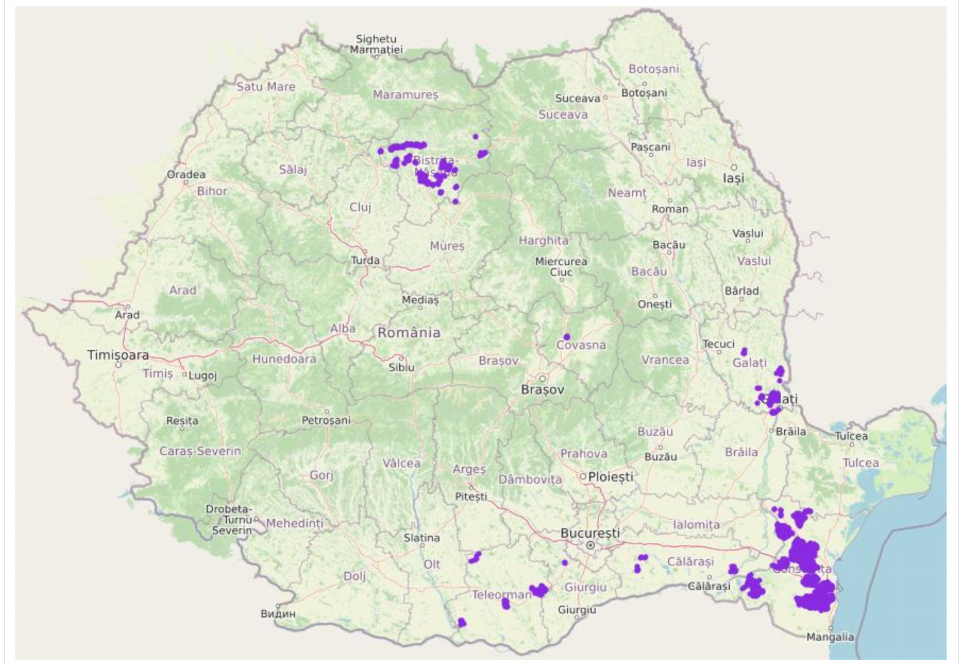
Figure 8. ArchTerr web site application: Romania map representing the validated archeological sites (purple blocks) from the seven counties involved in the